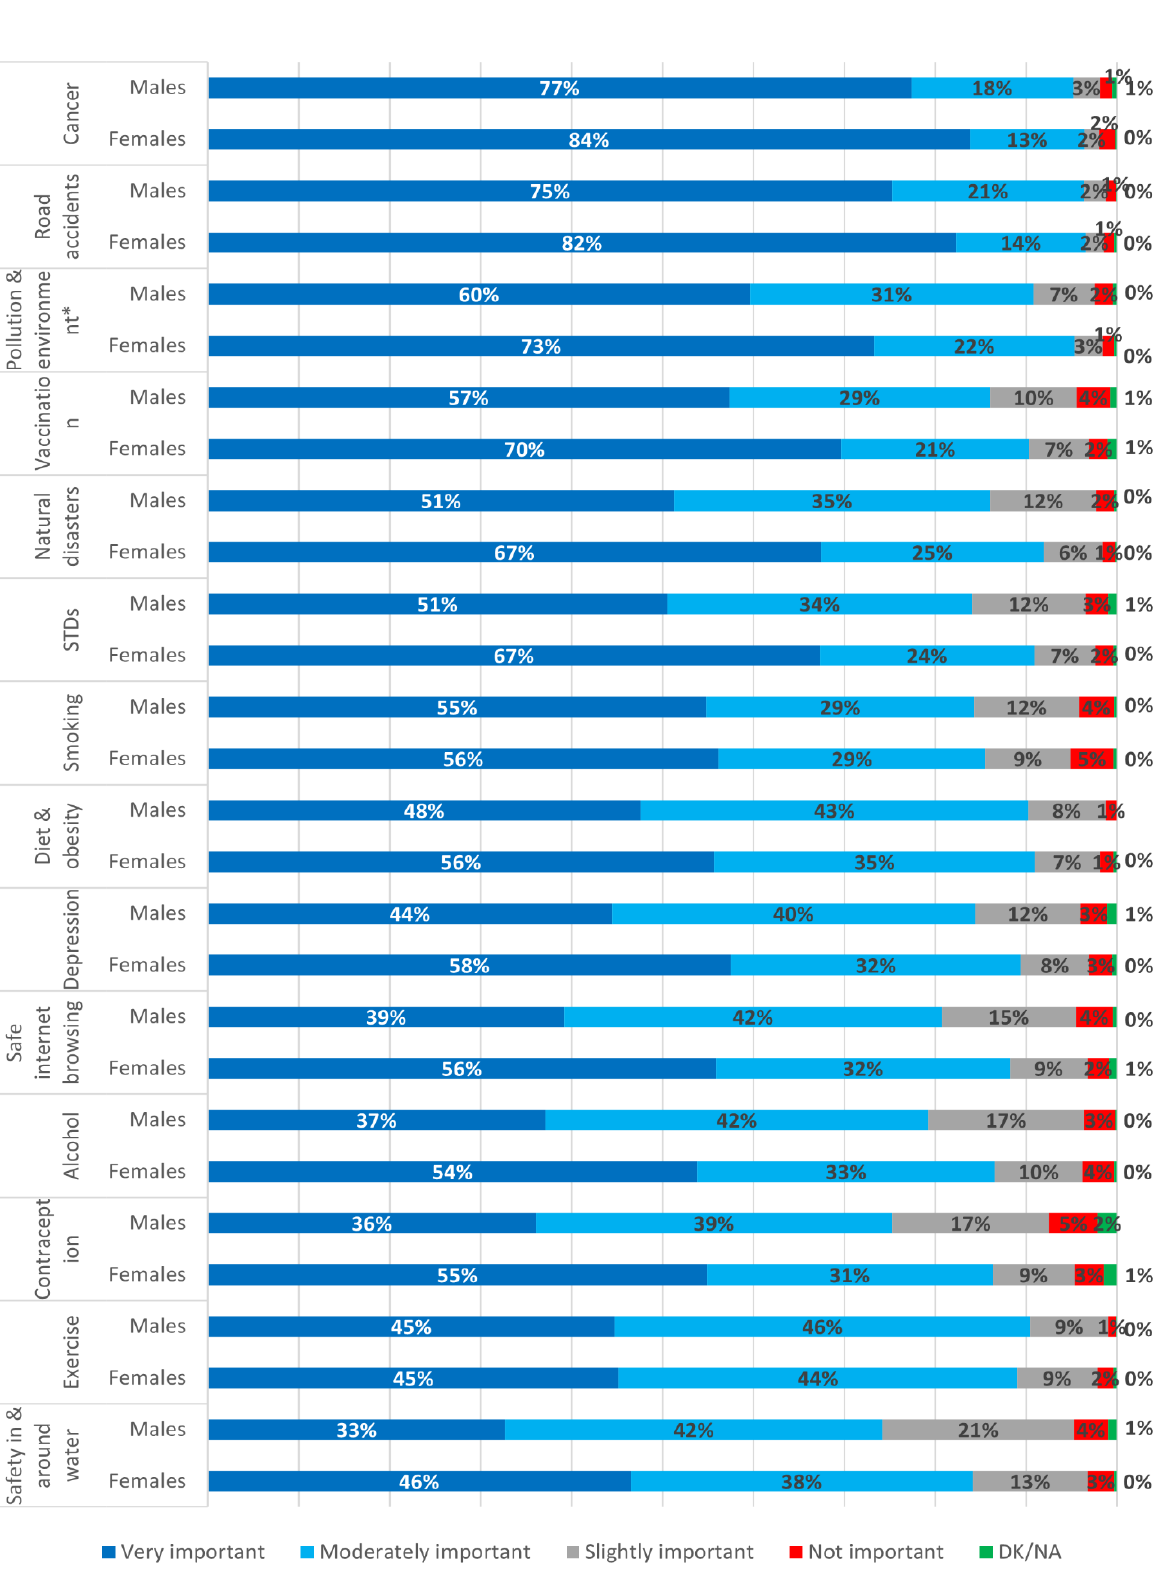
Figure 3. Importance of public health risks by sex; * Pollution and environment stands for air pollution and environmental protection; STDs, Sexually transmitted diseases; DK/NA, Do not know/No answer.